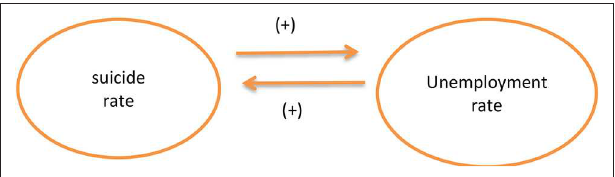
FIGURE 1 | Causal link between suicide rate and unemployment rate.